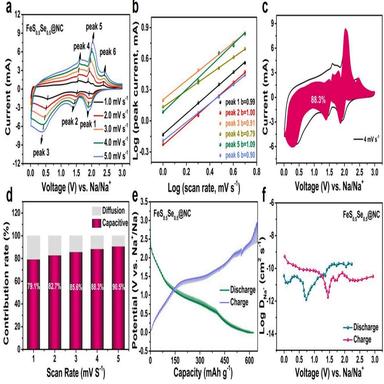
Kinetic analysis of sodium storage behavior of FeS0.5Se0.5@NC: (a) CV curves, (b) log (i) Versus log (v) plots at various redox peaks, (c) capacitive and diffusion-controlled contribution, (d) percentage of pseudocapacitive contribution at different scan speeds, (e) discharge–charge profiles for GITT, (f) diffusion coefficients of Na+ in discharge/charge process.